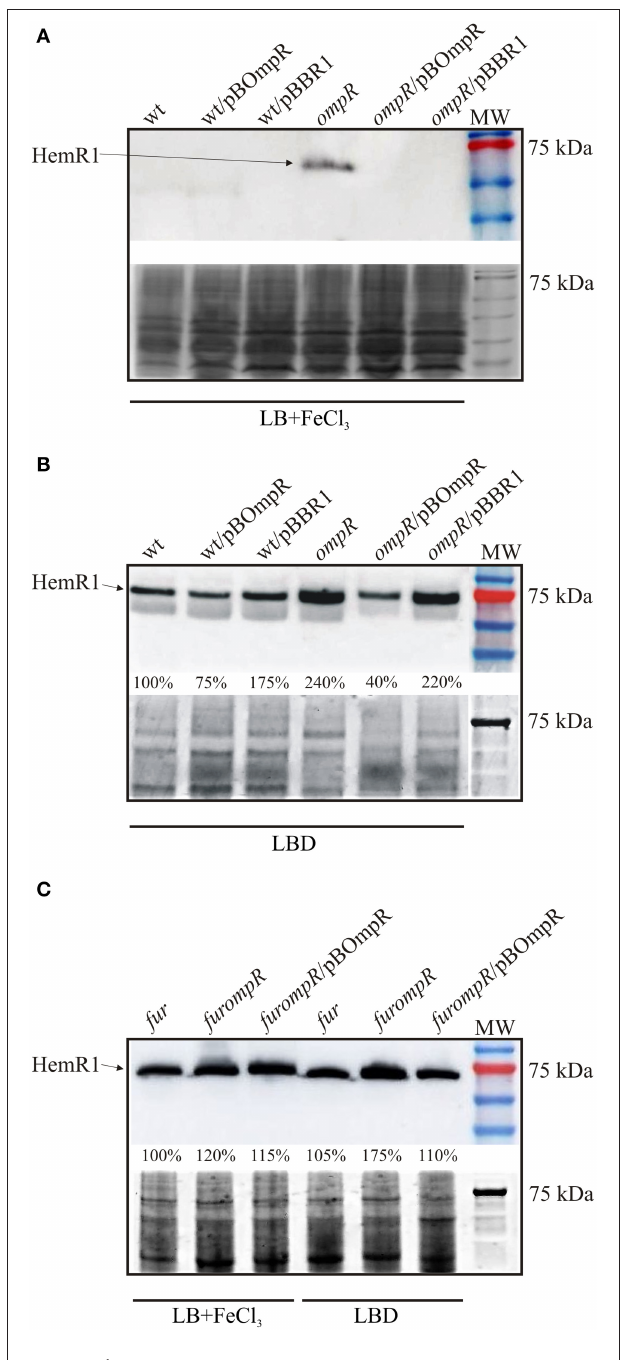
FIGURE 6 | Effect of iron, Fur, and OmpR on HemR1 production. The level of HemR1 in cell extracts of strains grown overnight in LB + FeCl 3 or LBD at 37 ◦ C analyzed by immunoblotting with a polyclonal HemR1 antibody. (A,B) The HemR1 level in the wild-type strain (wt), wt/pBBR1 (empty vector), wt/pBOmR (overexpression), the ompR mutant AR4, ompR /pBOmpR (complementation), and ompR /pBBR1 (empty vector) shown on Western blots (upper) with the stained gels as a loading control (bottom) . (C) The HemR1 level in the fur mutant background, i.e., fur mutant, furompR double mutant, and furompR /pBOmpR. The percentage values indicating the HemR1 band intensities in the tested strains relative to the wt (B) and fur mutant (C) , were